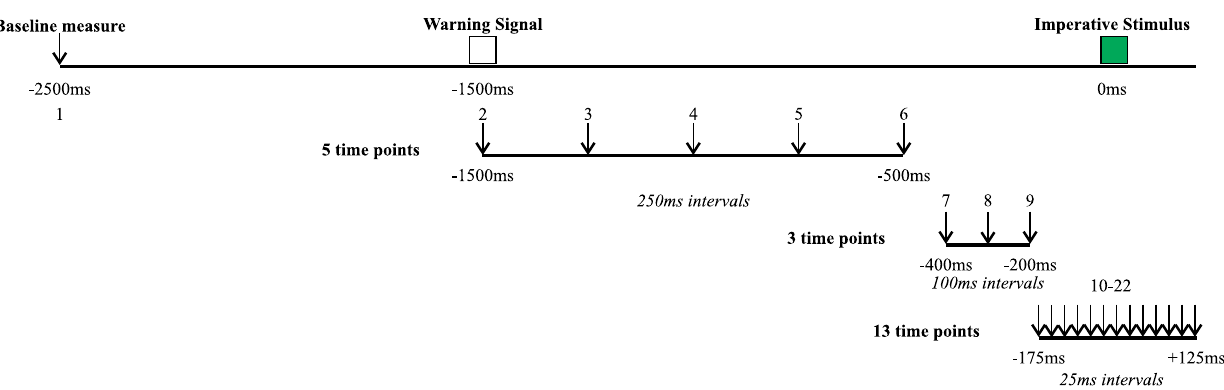
Figure 1. Visual representation of the TMS stimulation points with respect to imperative stimulus onset, represented by downwards pointing